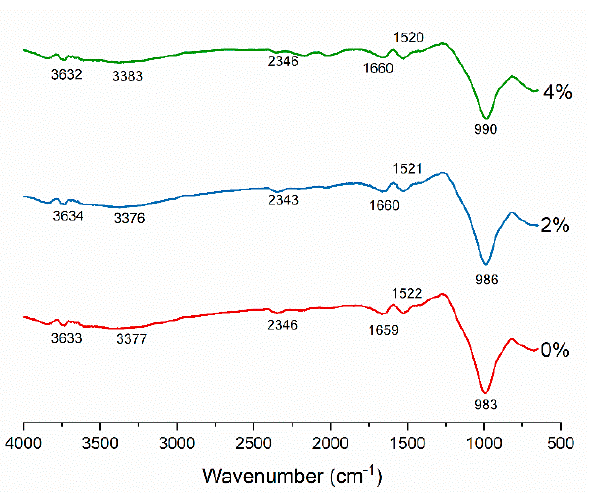
Figure 10. IR spectra of un-exposed fly ash geopolymers with varying silica fume content addition.